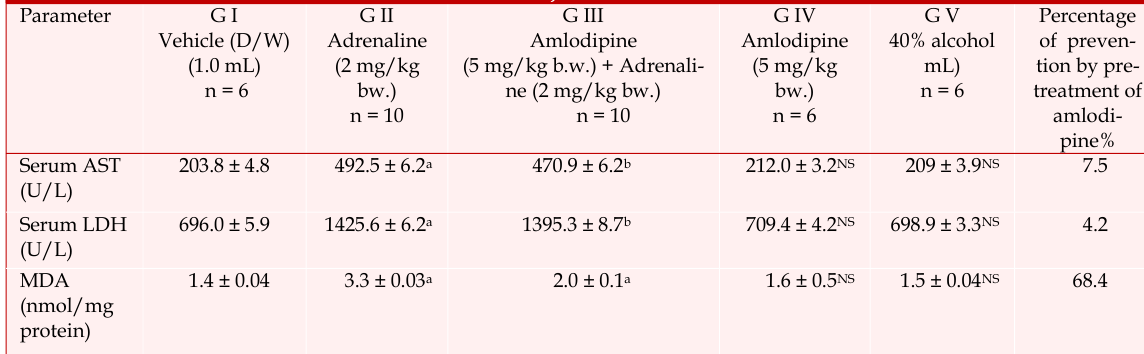
Showing the effect of pretreatment of amlodipine on serum enzymes and myocardial MDA concentration after the 2 nd injection of